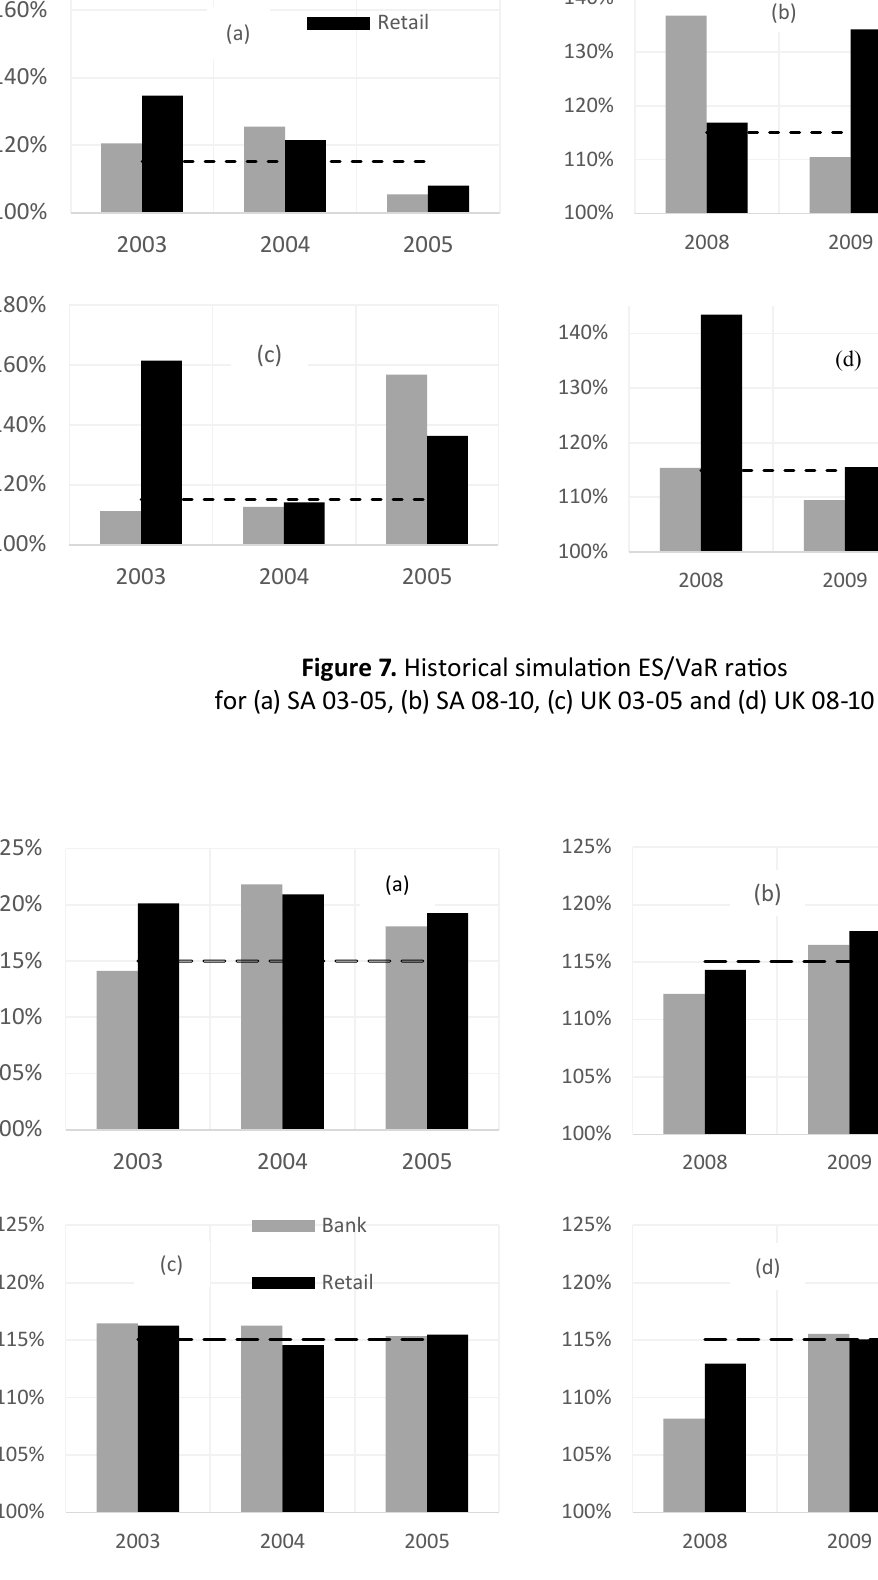
Figure 8. Variance-covariance ES/VaR ratios for (a) SA 03-05, (b) SA 08-10, (c) UK 03-05 and (d) UK